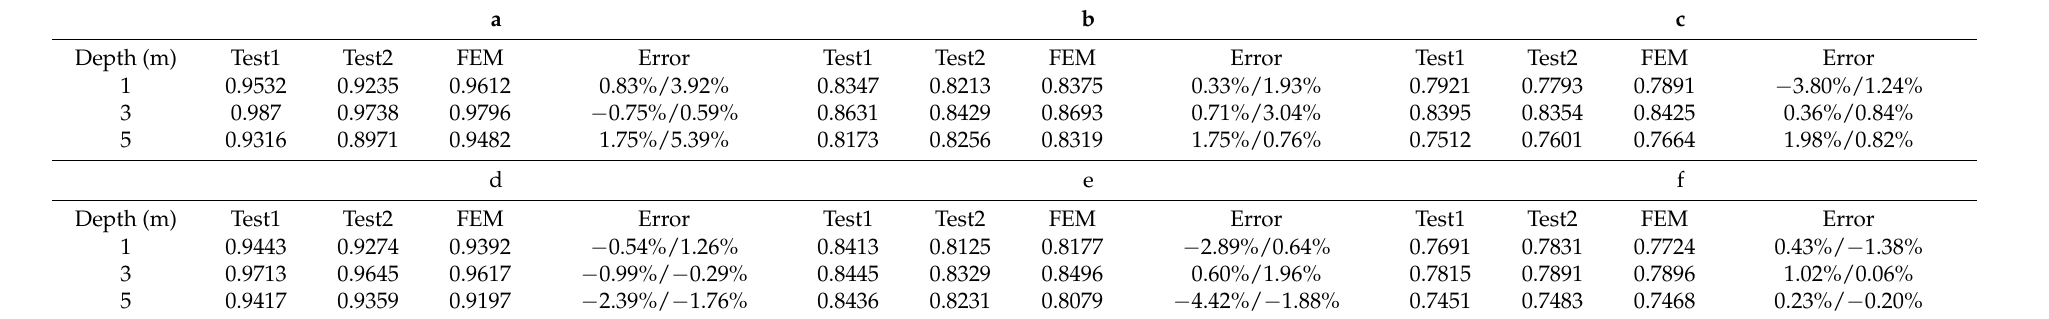
Table 4. Compaction coefficients of compacted soil